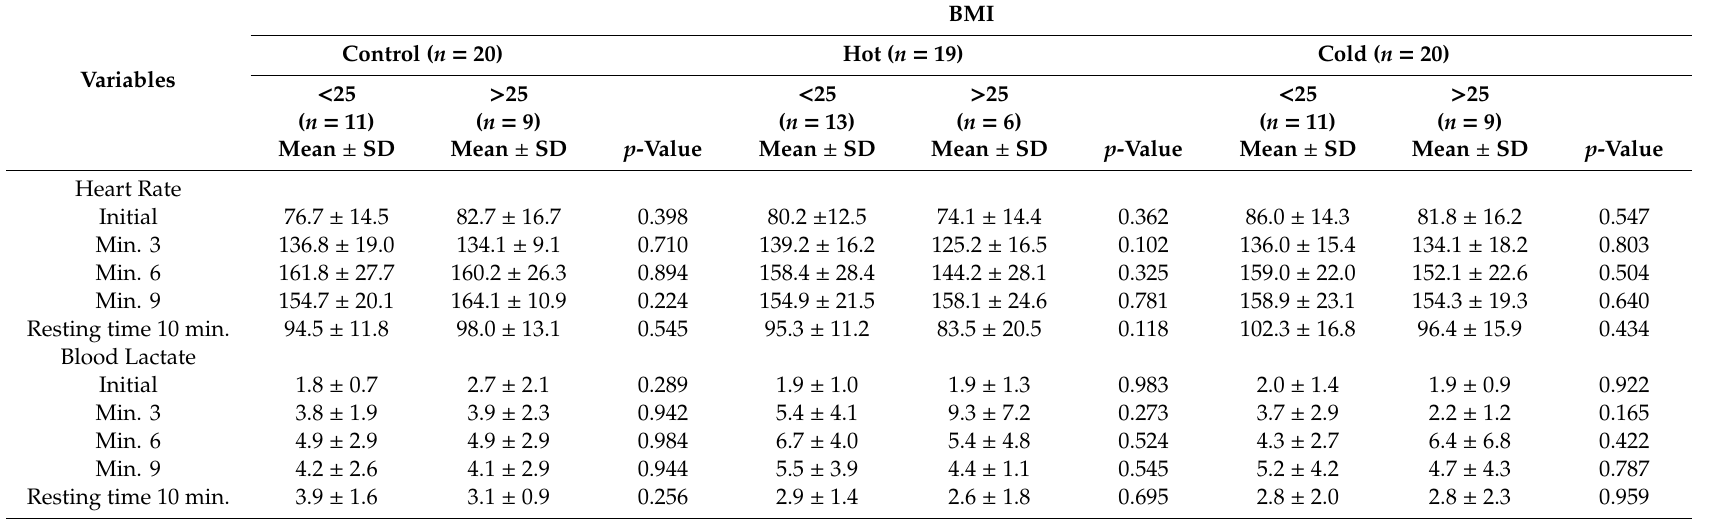
* Statistically significant di ff erences. SD, standard